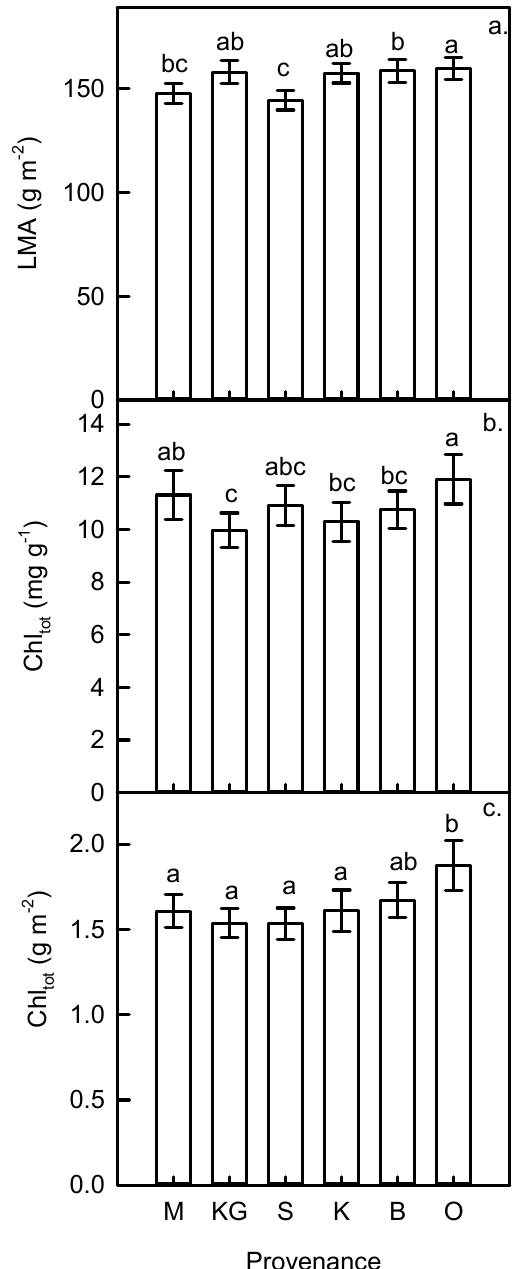
Figure 2. Structural needle traits of Abies alba seedlings from northern provenances (means ± SE). Data from 2019 and 2020 are pooled. ( a ) Leaf mass-to-area ratio ( LMA ); ( b ) total needle chlorophyll concentration ( Chl tot mg g − 1 ); ( c ) total needle chlorophyll content ( Chl tot g m − 2 ). The results of ANOVA are shown in Table 4. The same letters above columns indicate that the mean values are not different in Tukey’s test at p < 0.05 ( n = 20, n —number of seedlings per provenance). M—“Mi ę dzylesie”, KG—